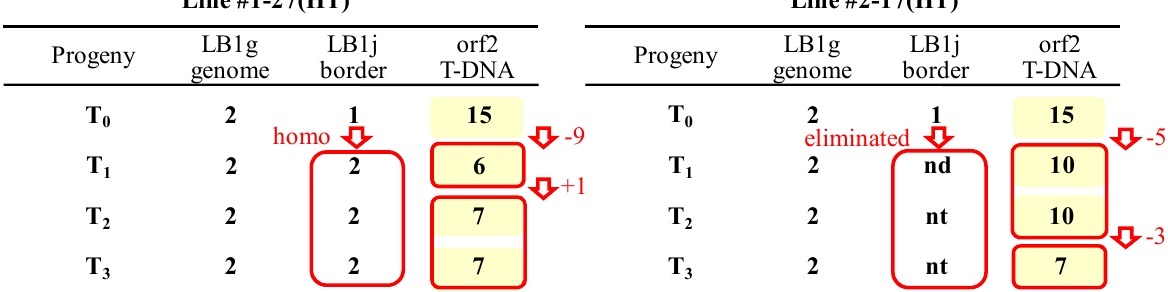
Figure 7. Shift of the relative abundance of target regions LB1g, LB1j, and orf2 of T-DNA insertion locus LB1-RB2 analyzed for two selfed lines, #1-27(HT) and #2-17(HT) by quantitative real-time